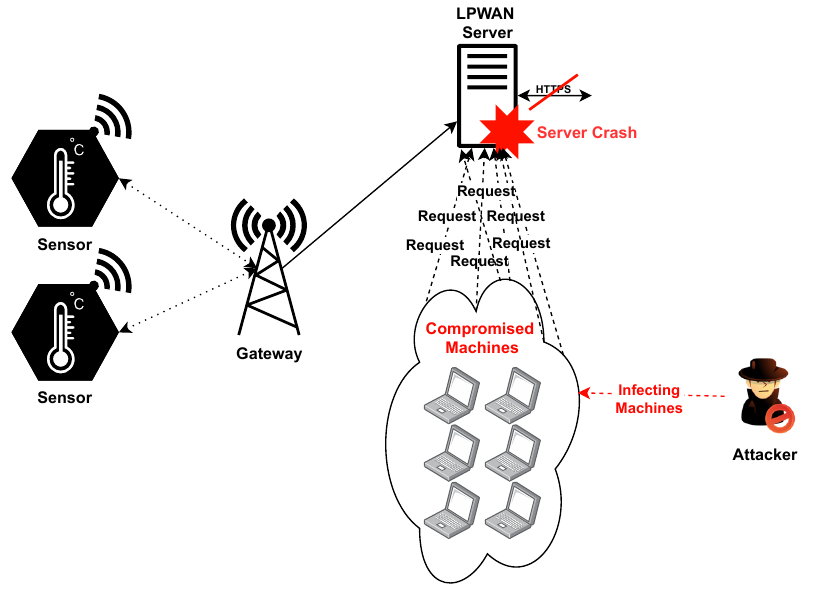
Figure 11. Distributed Denial of Service